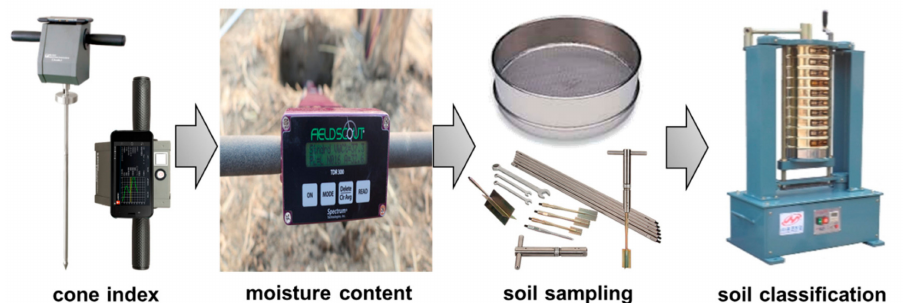
Figure 1. Measurement process of soil physical properties.